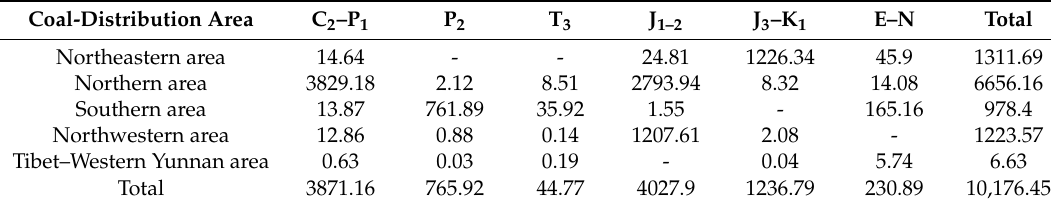
Table 3. Coal reserves of China among different coal-distribution areas in different coal-forming periods (unit: 10 9 t).